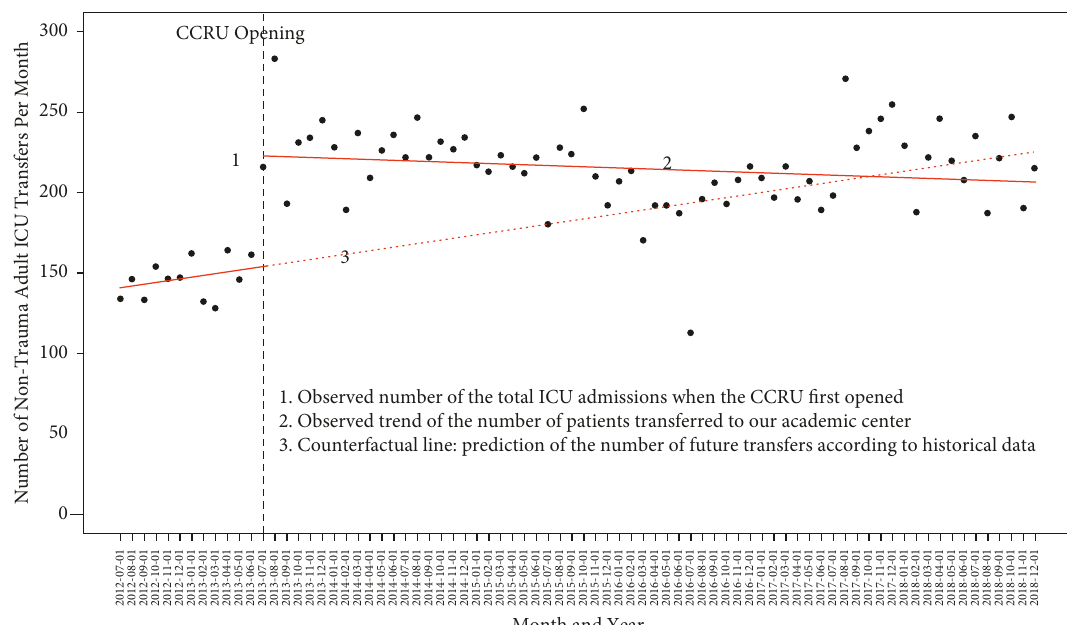
Figure 3: Interrupted time series (ITS) demonstrating the trend of non-trauma adult patients who were transferred from other hospitals to any adult intensive care unit (ICU) at our academic medical center, University of Maryland Medical Center (UMMC). The CCRU was opened in July 2013. Abbreviations: CCRU, critical care resuscitation unit; ICU, intensive care unit; UMMC, University of Maryland Medical